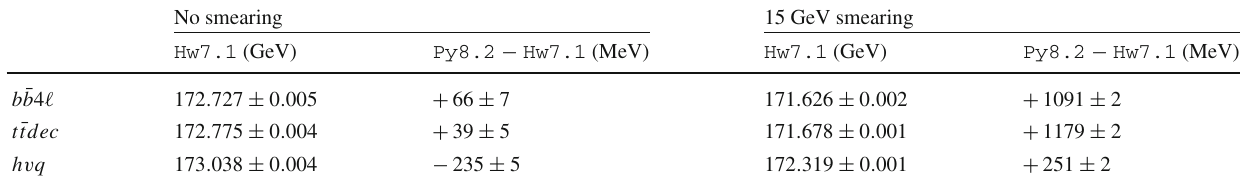
Table 8 m Wb peak position for m t = 172.5 GeV obtained with the three different generators, showered with Herwig7.1 ( Hw7.1 ). The j differences with Pythia8.2 ( Py8.2 ) are also shown No smearing 15 GeV smearing